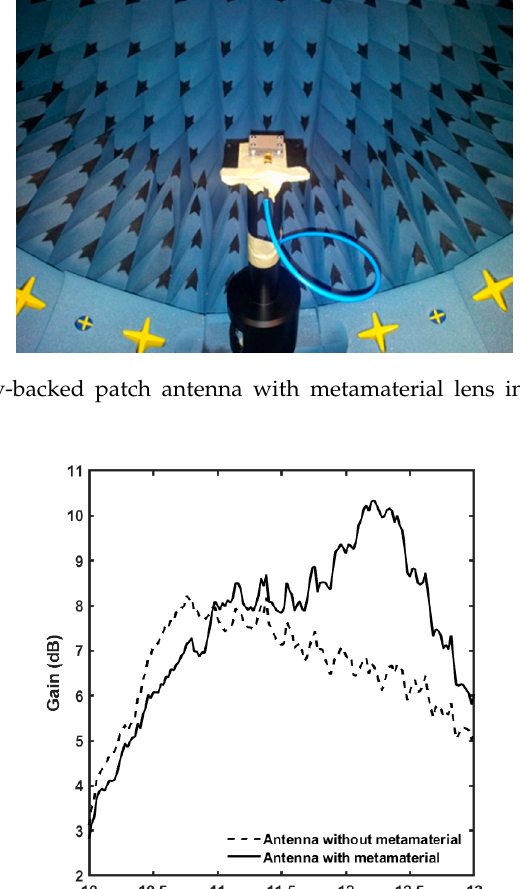
Figure 13. Measured gain versus frequency of SIW cavity-backed patch antenna with and without